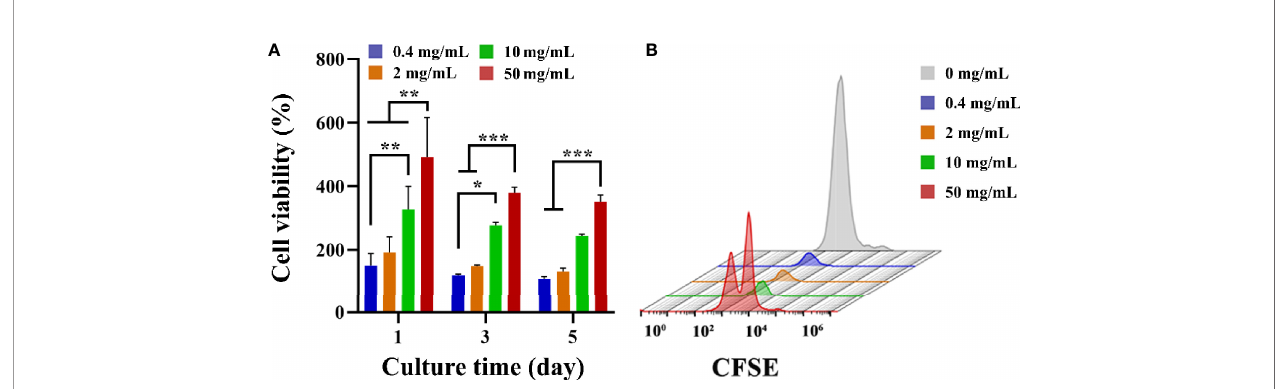
FIGURE 2 | (A) T cell viability on different groups treated with HFD after 1, 3 and 5 d. Data are mean ± SD (n = 3) (* p < 0.05, ** p < 0.01, *** p < 0.001). (B) Representative CFSE diagram on various samples.